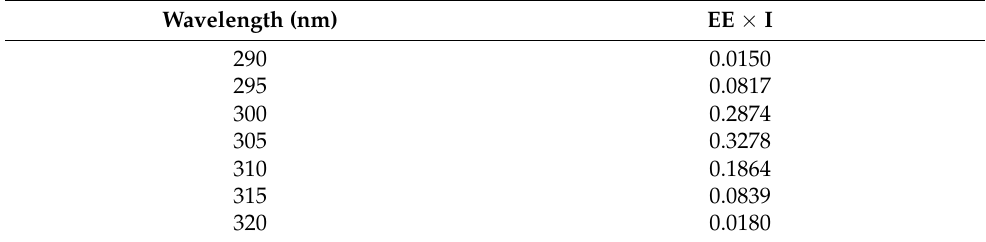
Table 1. EE( λ ) × I( λ ) values used in calculation of sun protection factor (SPF).